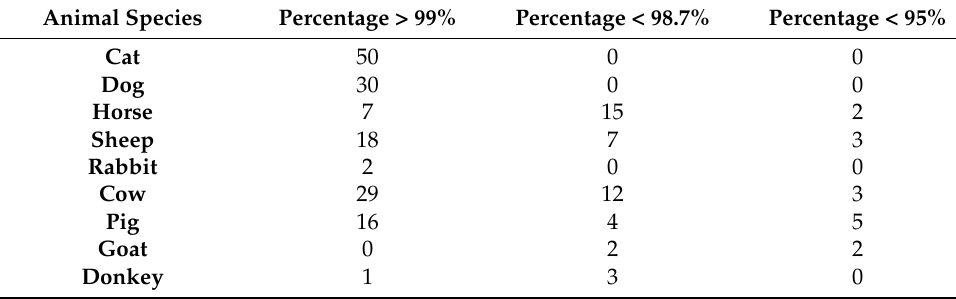
Table 5. Percentage of identity among the sequences obtained.